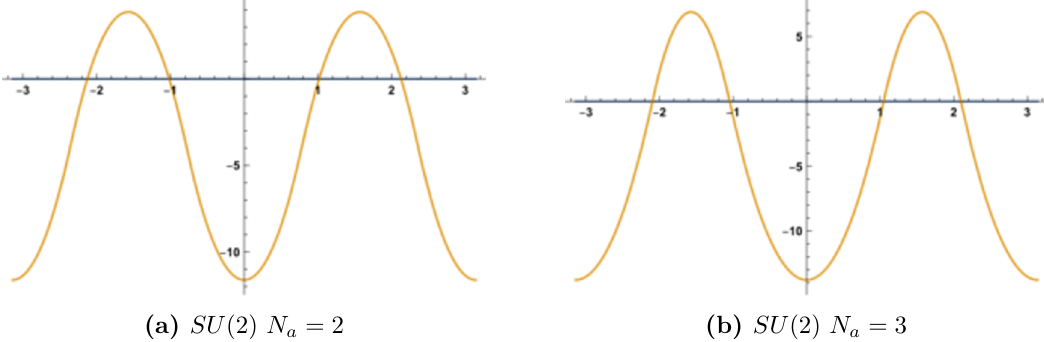
Figure 3. ( Re F , Im F ) | ∆= − iπ of rank-1 SYM with N a = 2 , 3 adjoint chiral multiplets.